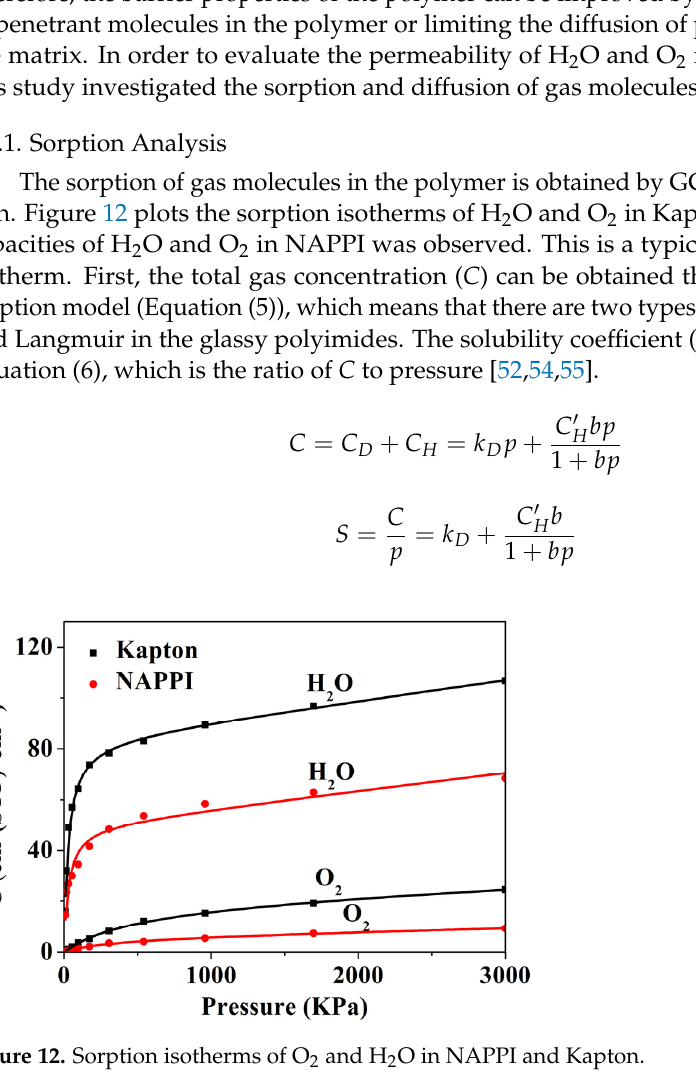
Figure 11. Radial distribution function ( g H-O ( r )) of H (in amide group) and O (in amide group and imide ring) in NAPPI.